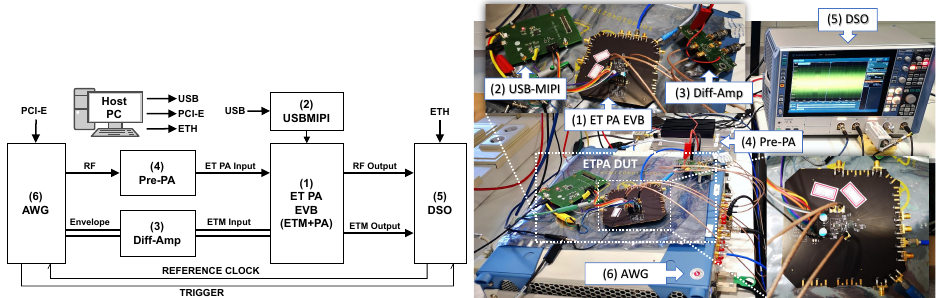
Figure 8. Simplified block diagram and picture of the ET PA linearization test bench. The labels are as follows: (1) ET PA EVB: HiSilicon’s ET PA evaluation board including ETM and RF ET PA; (2) USB-MIPI: FTDI USB to MIPI bridge; (3) Diff-Amp: Differential amplifier THS4508RGT from Texas Instruments; (4) Pre-PA: RF pre-amplifier ZHL-42 from Minicircuits; (5) DSO: Digital oscilloscope RTP084 from Rohde and Schwarz; (6) AWG: Arbitrary waveform generator M8190A from